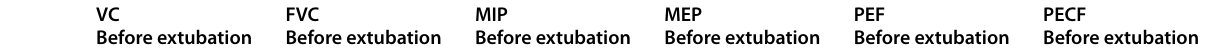
Table 2 Correlations between physiological parameters before and after extubation